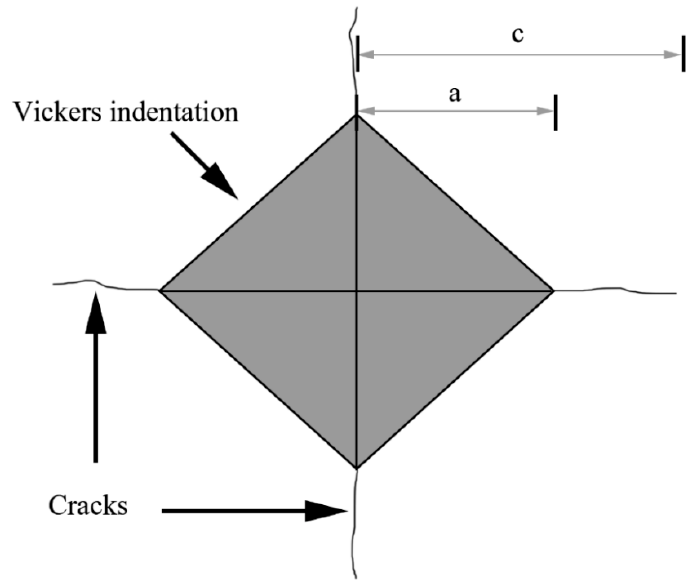
Figure 2. Schematic diagram of the indentation.